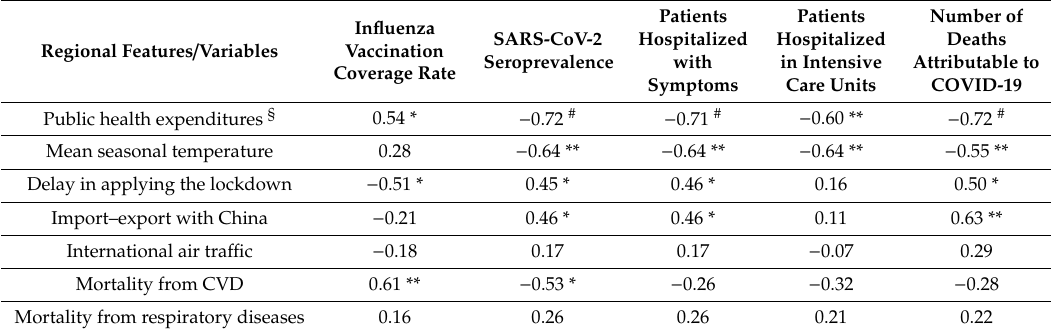
Table 1. Pearson’s correlation analysis between possible confounders and influenza vaccination coverage rate and COVID-19 outcomes.